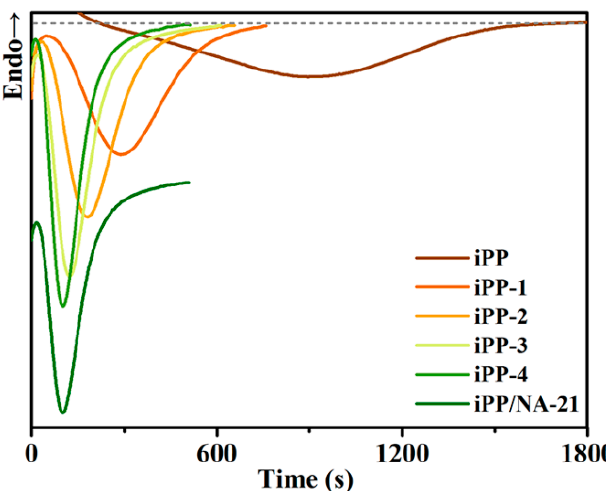
Figure 6. The isothermal crystallization curves for the iPP/A12C-Li composites.